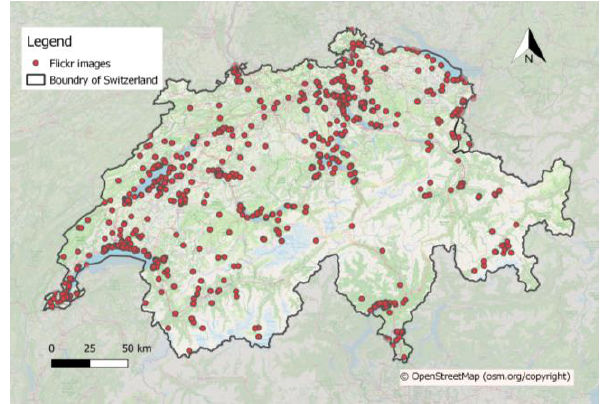
Figure 1: Location of Flickr images with bird tags in Switzerland